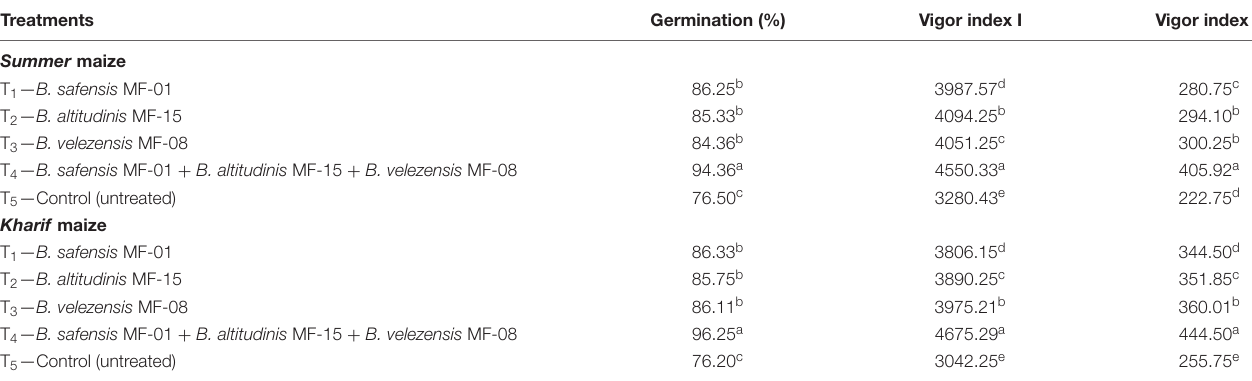
TABLE 2 | Effects of seed biopriming and microbial intervention on germination (%) and vigor indices in maize grown in Summer and Kharif season under nethouse experiments at 30 days of sowing. Treatments Germination (%) Vigor index I Vigor index II Summer